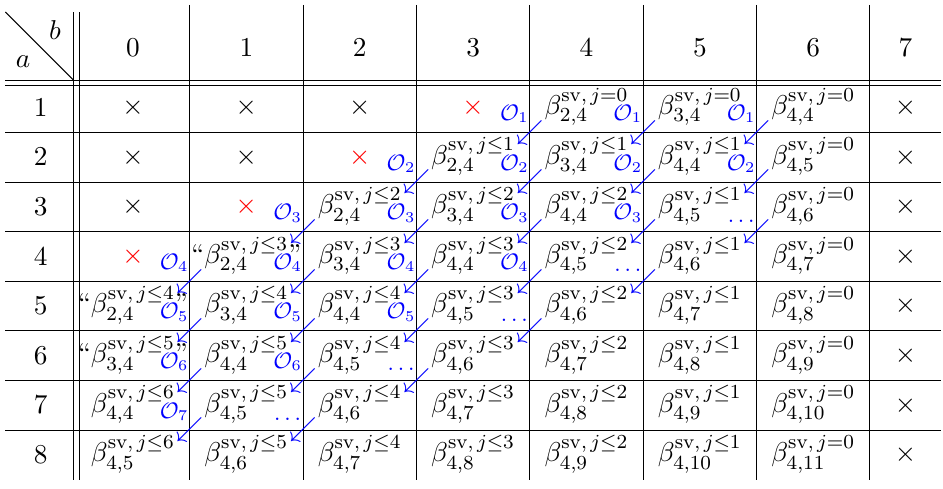
, or alternatively β sv ,j , obtained from Poincaré sums over 4 ,k k, 4